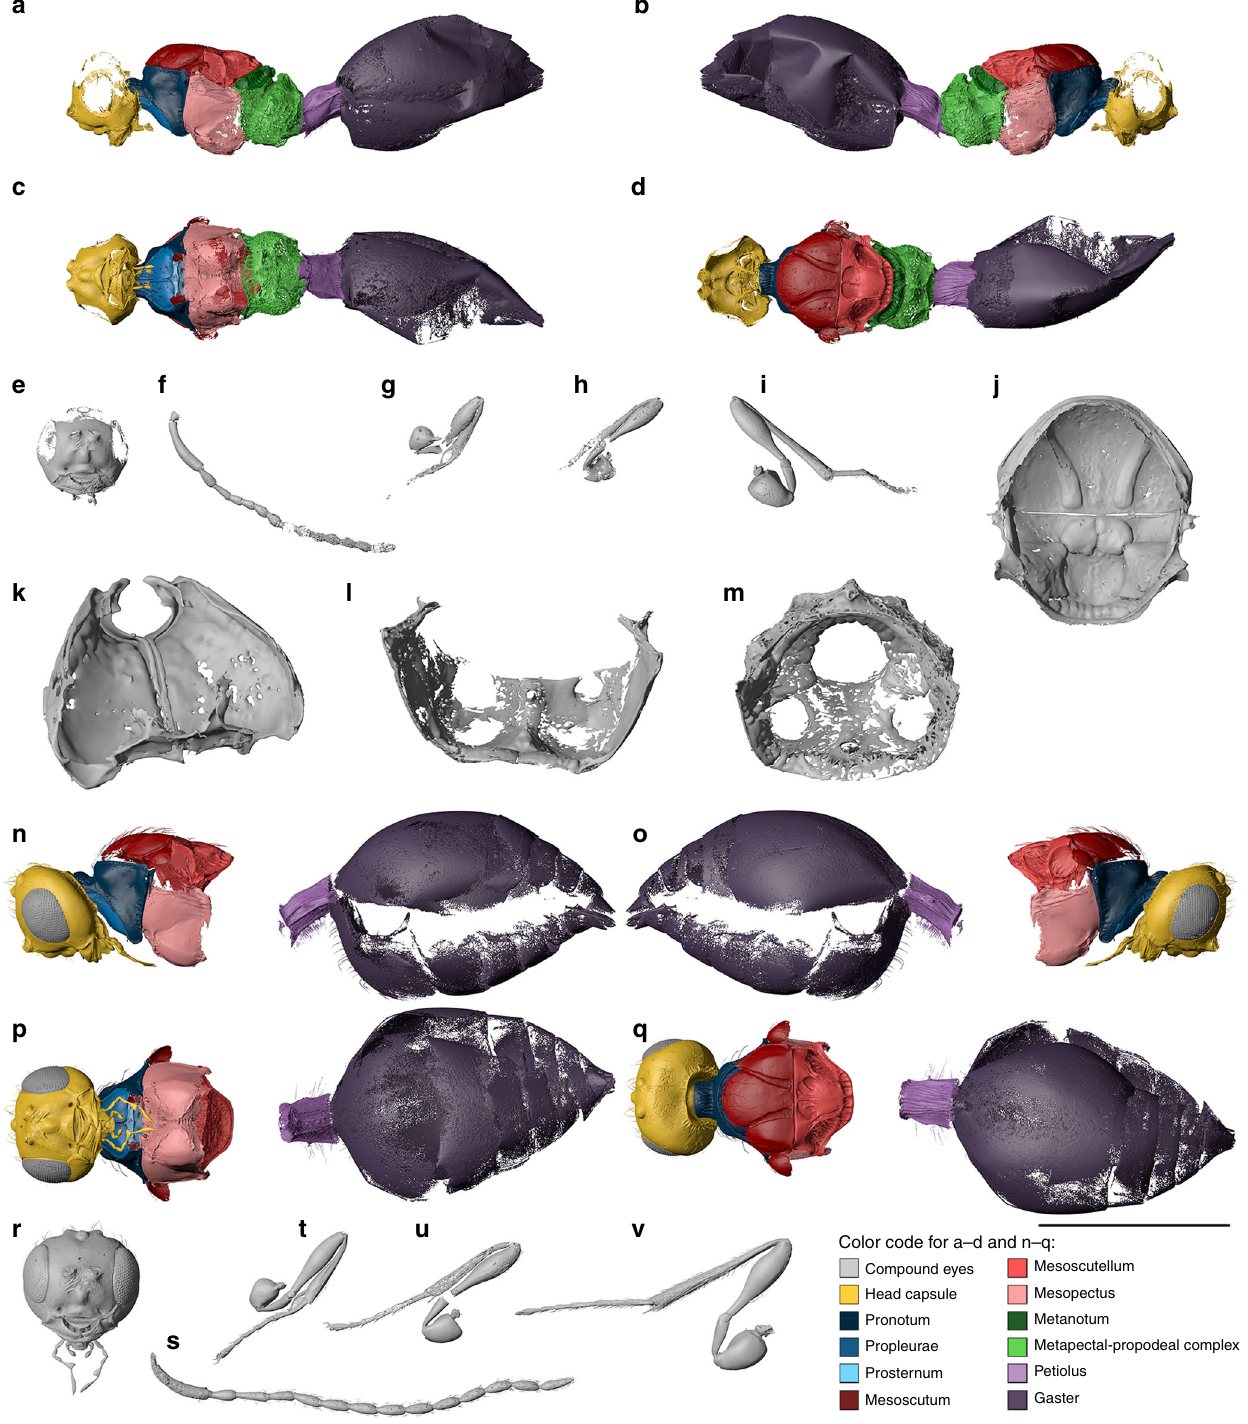
Fig. 5 Digital reconstruction of Xenomorphia handschini gen. & sp. nov. (Diapriidae: Diapriinae: Spilomicrini). Female holotype NMB F3042 ( a – m ) and male paratype NMB F2543 ( n – v ). Habitus ( a – d ), head ( e ), left antenna ( f ), right foreleg ( g ), right midleg ( h ), left hind leg ( i ). Internal anatomical structures ( j – m ): mesonotum ventral view ( j ), propectus dorsolateral view ( k ), mesopectus anterior view ( l ), metapectal-propodeal complex anterior view ( m ). Habitus ( n – q ), head ( r ), right antenna ( s ), right foreleg ( t ), right midleg ( u ), right hind leg ( v ). Scale bar: a – i , n – v = 1 mm; j = 500 µ m; k = 250 µ m; l , m = 400 µ